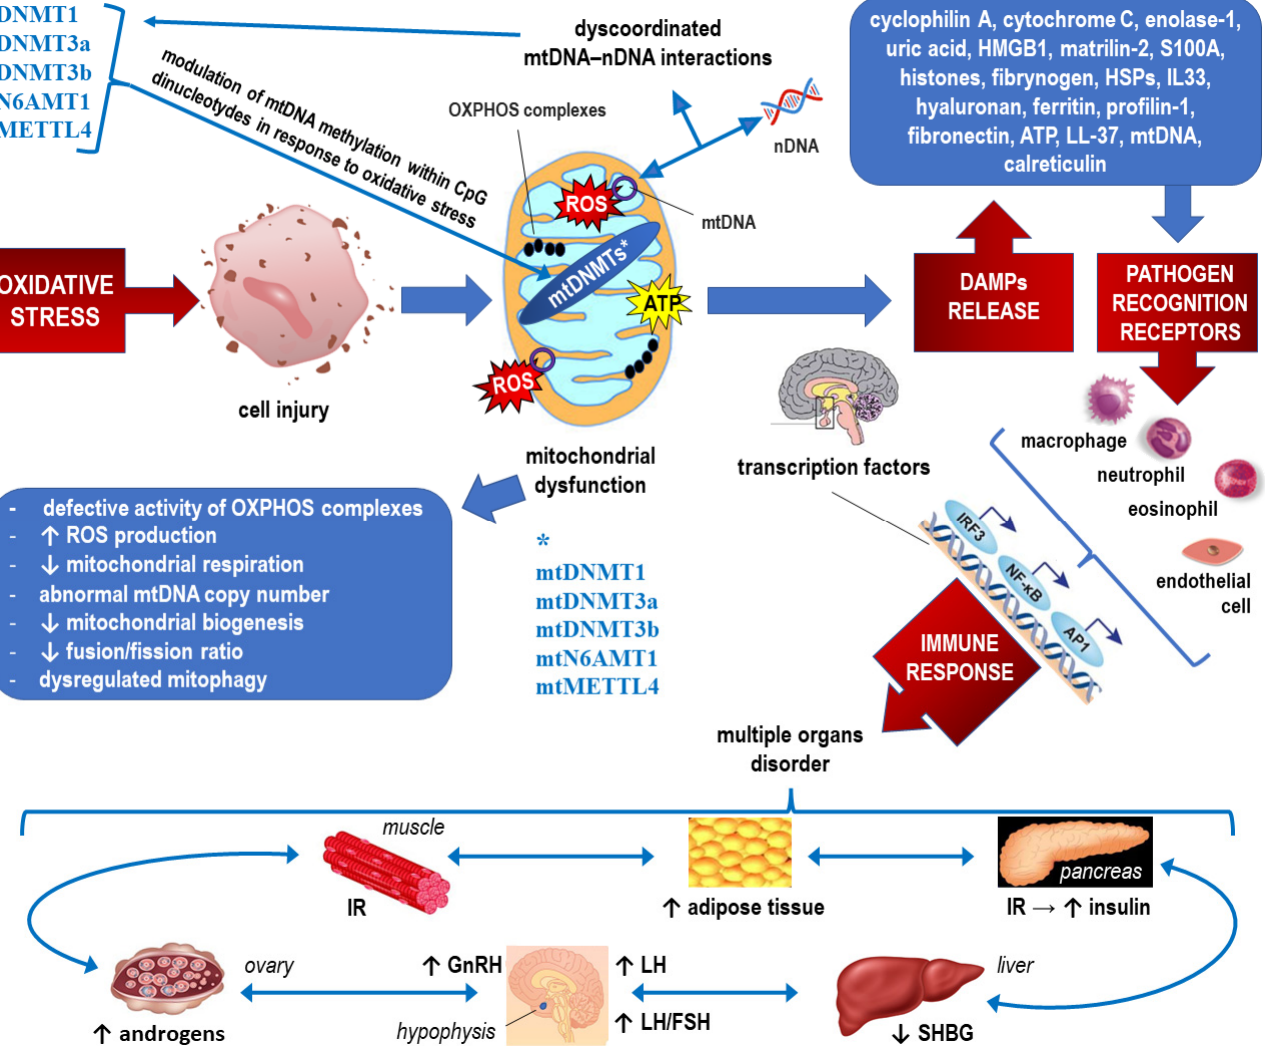
Figure 4. Epigenetics of mitochondrial dysfunction in PCOS. See the main text (Section 2.2) for detailed explanations. PCOS is caused by a vicious cycle of androgen excess, insulin resistance, low-grade inflammation, obesity and increased oxidative stress [91]. * Mitochondrial DNA methyltransferase 1, DNA methyltransferase 3 alpha, DNA methyltransferase 3 beta, N-6 adenine-specific DNA methyltrasferase 1, and methyltransferase 4, respectively